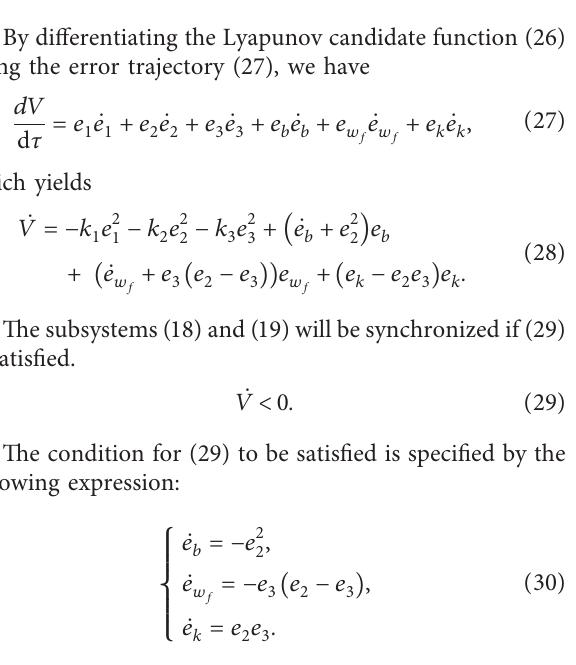
( in red ) towards 3